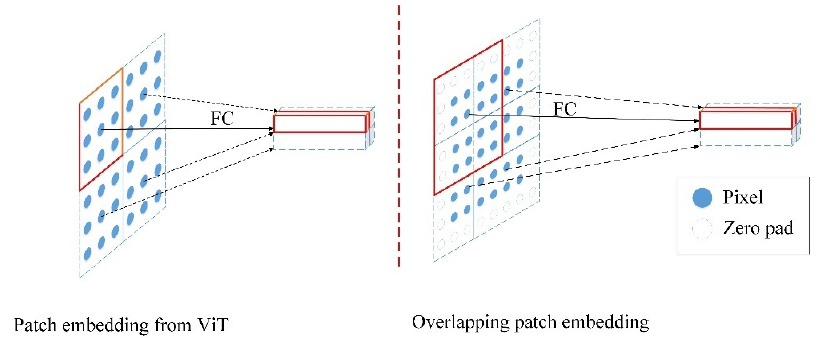
Figure 3. Comparison of original Patch embedding form ViT and improved Overlapping patch